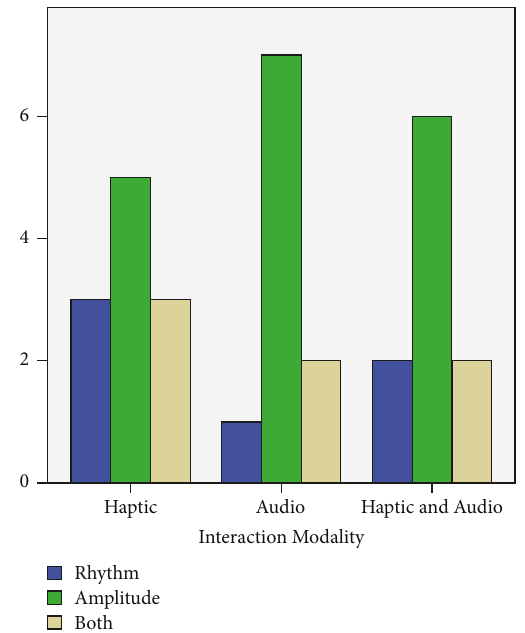
Figure 5: Participants reported that different levels of amplitude were difficult to distinguish in each